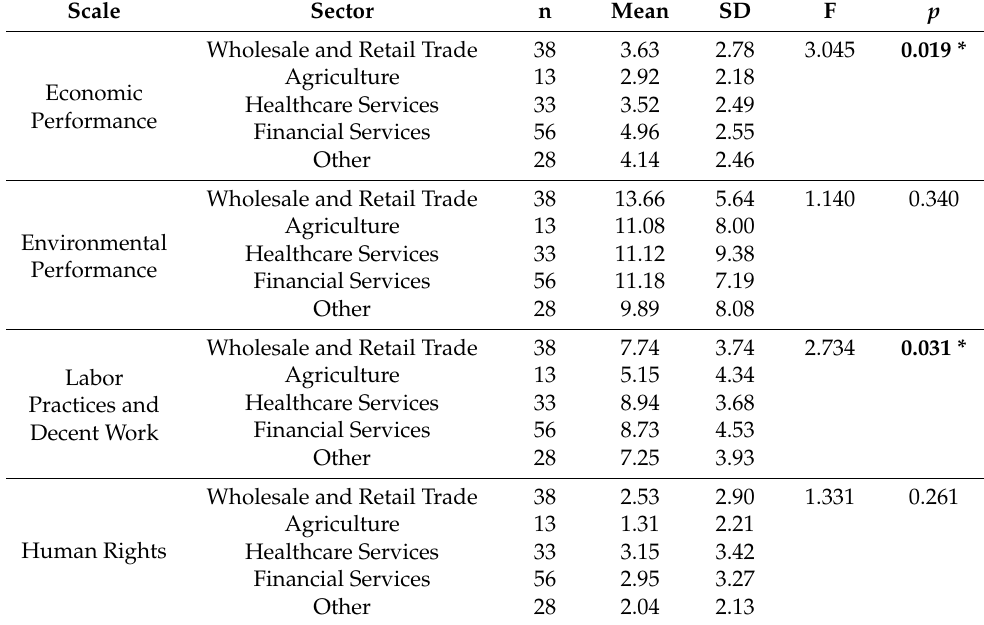
Table 8. ANOVA test results for the comparison of the economic, environmental, and social perfor- mance indicator disclosures subject to